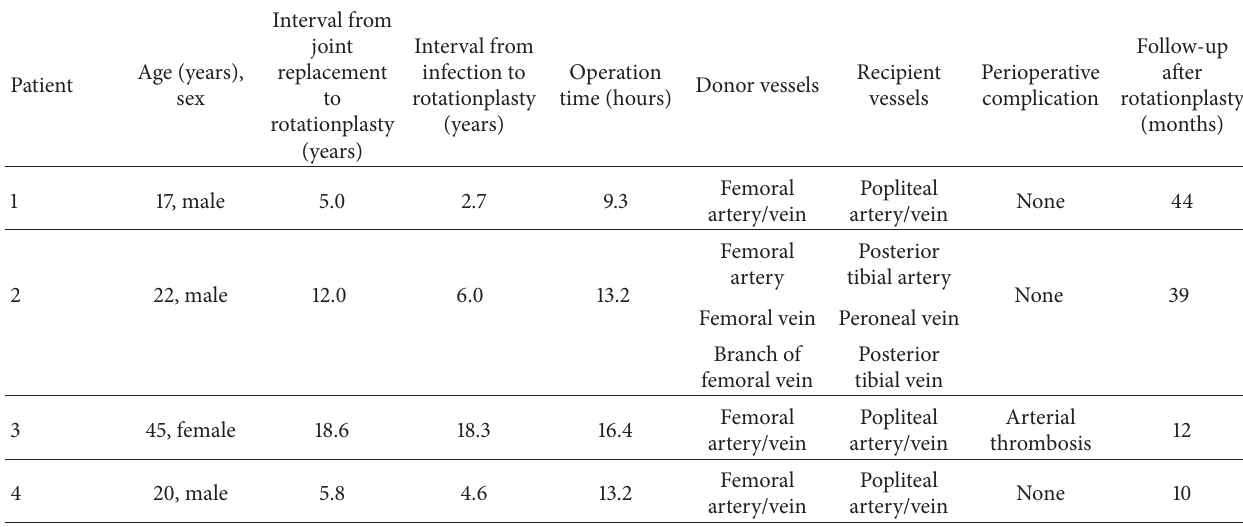
Table 1: Patient characteristics and operative